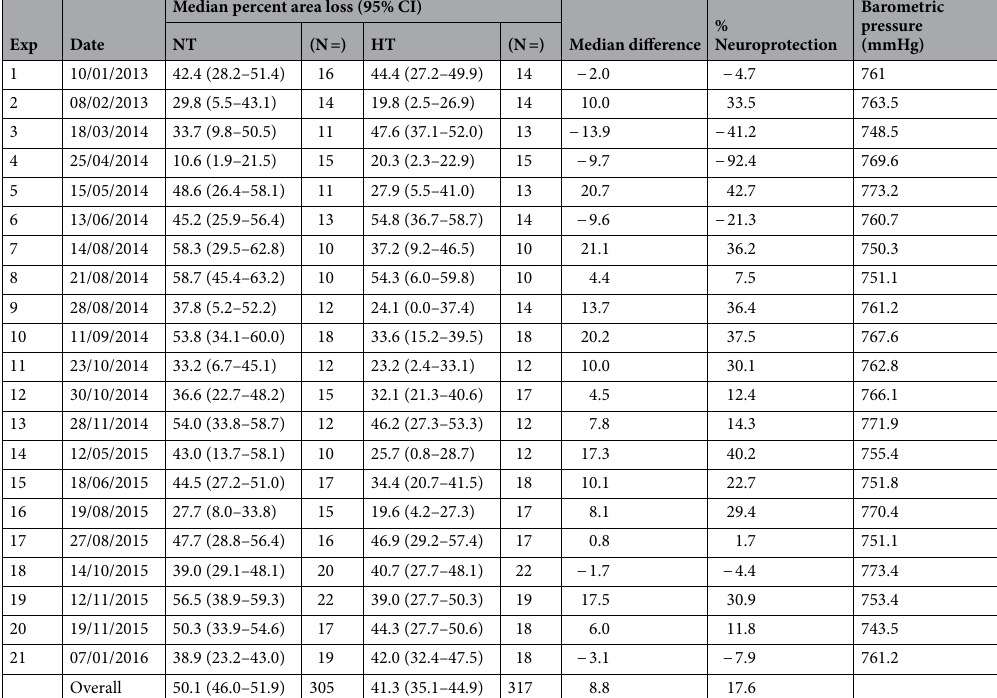
Table 1. Severity of injury and hypothermic neuroprotection. Median (95% CI) percent area loss in the NT and HT groups, and percent neuroprotection in the HT group, across all 21 experiments. The median difference in area loss between the two groups (median NT–median HT) was used to calculate percent neuroprotection in the HT group. Overall median area loss, median difference, and percent neuroprotection were calculated by combining all the animals in the NT (n = 305) and HT (n = 317) groups. The degree of neuroprotection provided by HT was not correlated with initial injury severity (median area loss in the NT group; Kendall’s τb, p = 0.83). As a potential factor associated with experimental variability, local barometric pressure on the morning of each experiment is also provided. Data from experiments 7–11 was previously published 6